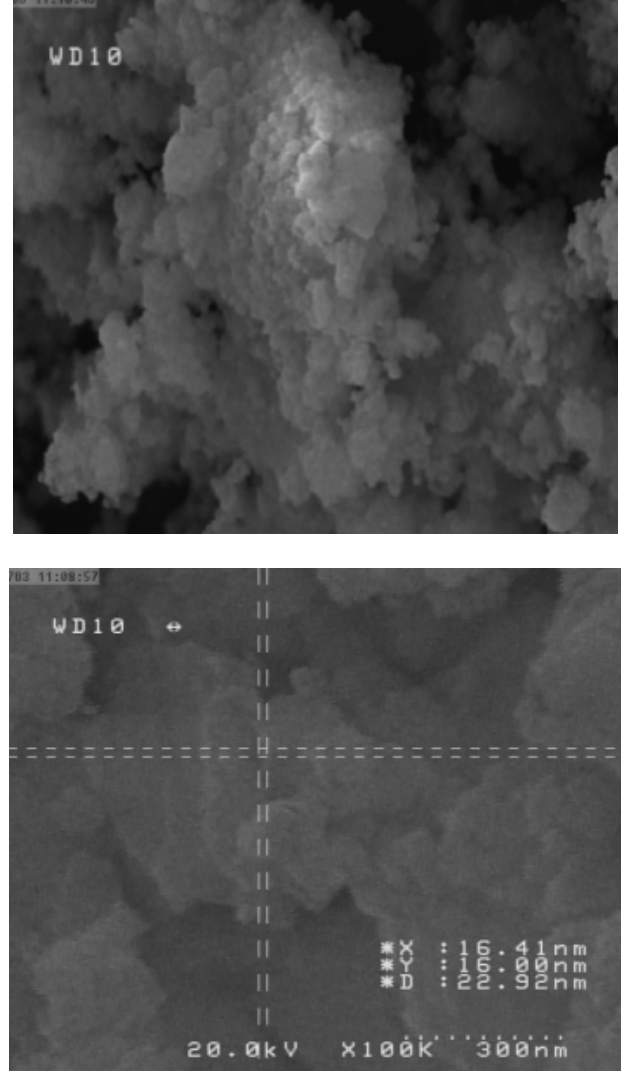
Fig. 8. SEM image of the prepared perlite